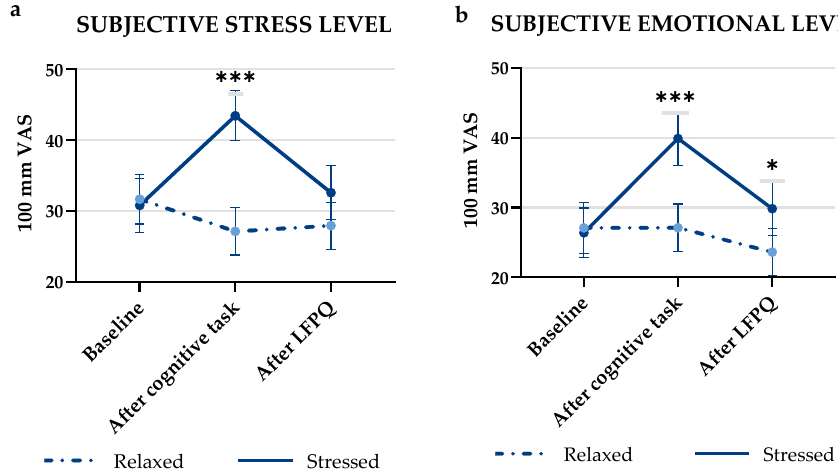
Figure 3. ( a ) Mean ( ± SEM) subjective stress levels measured at baseline, after the cognitive task and after performing the Leeds Food Preference Questionnaire (LFPQ), rated on a 100 mm visual analogue scale. ( b ) Mean ( ± SEM) subjective emotional levels measured at baseline, after the cognitive task and after performing the Leeds Food Preference Questionnaire (LFPQ), rated on a 100 mm visual analogue scale. Stars indicate level of significance of p -values. *: p < 0.05, ***: p < 0.001.